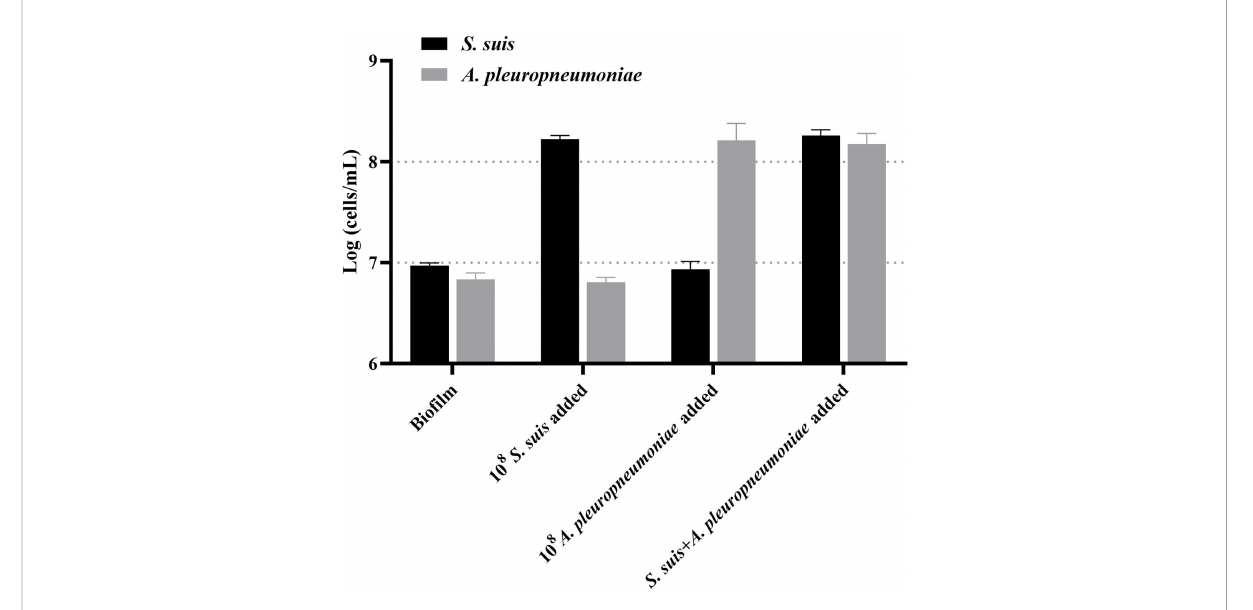
FIGURE 6 TaqMan real-time PCR analysis of bio fi lm samples, including: no added planktonic bacteria, 10 8 CFUs/mL S. suis , 10 8 CFUs/mL A. pleuropneumoniae , or the two bacterial species; data are expressed as mean ± standard deviation (n =